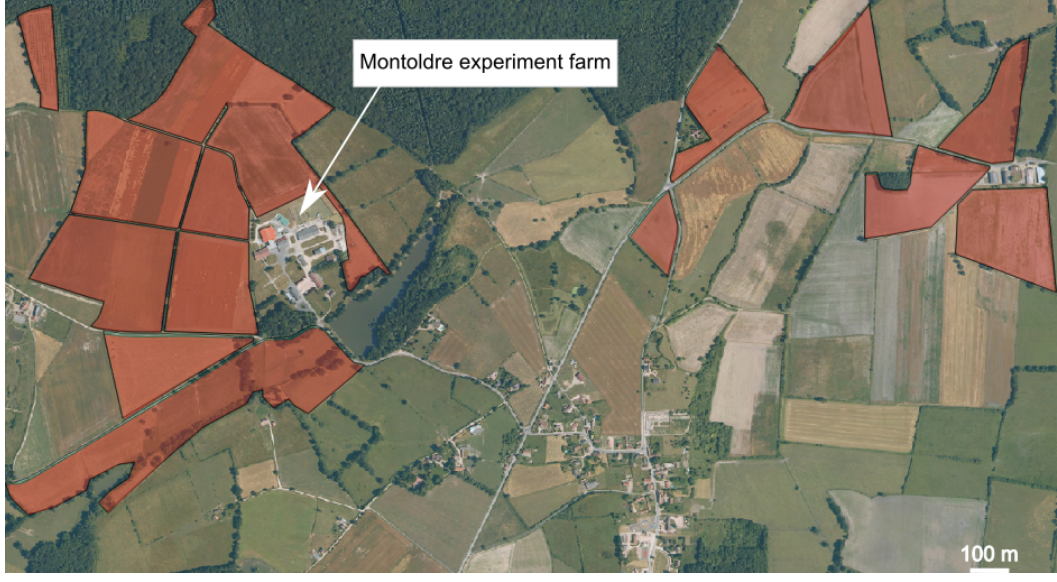
Figure 6. Montoldre experiment farm.